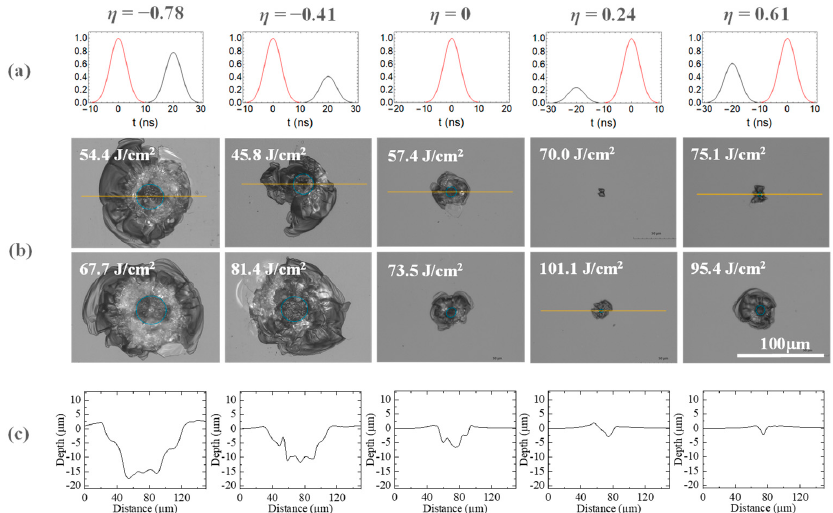
Figure 5. The representative damage morphology near threshold with different energy ratio η at the 20 ns delay. ( a ) The first row shows the dual-pulse train with various shape factors η . ( b ) The second and third rows shows the optical microscopic images of the damage sites while the applied fluence of main-pulse ϕ main are marked in each image. All the images have the same scale. ( c ) The last row shows the line-out profile corresponding to the positions of the damage sites marked in orange. The sample surface is located at 0µm on the vertical axis.